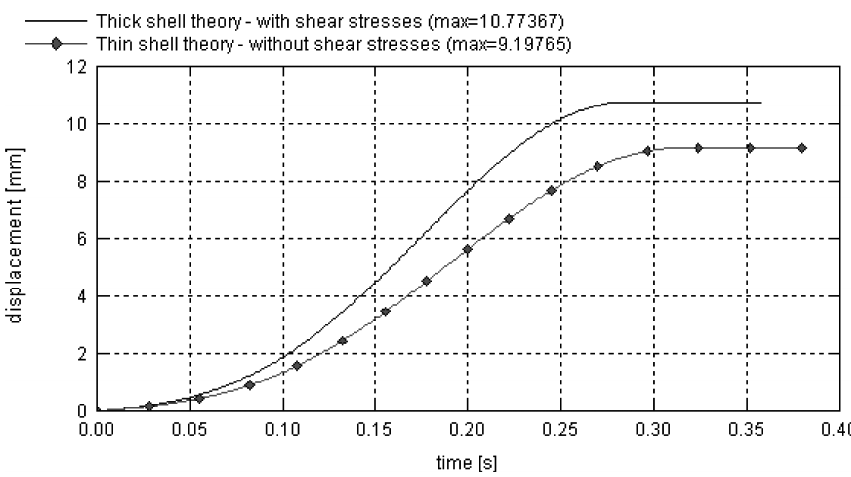
Fig. 14. Radial displacements for a cylinder subjected to a ring of pressure ( t = 0.5 mm ).